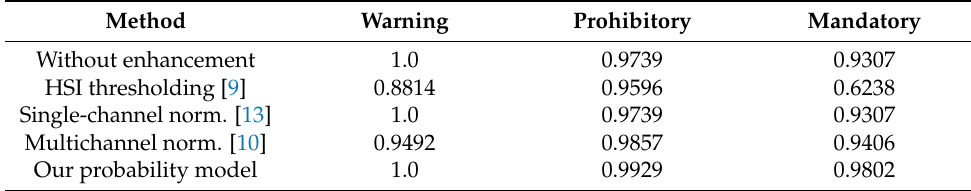
Table 3. Detection accuracy (20) of Selective Search on the Swedish dataset.